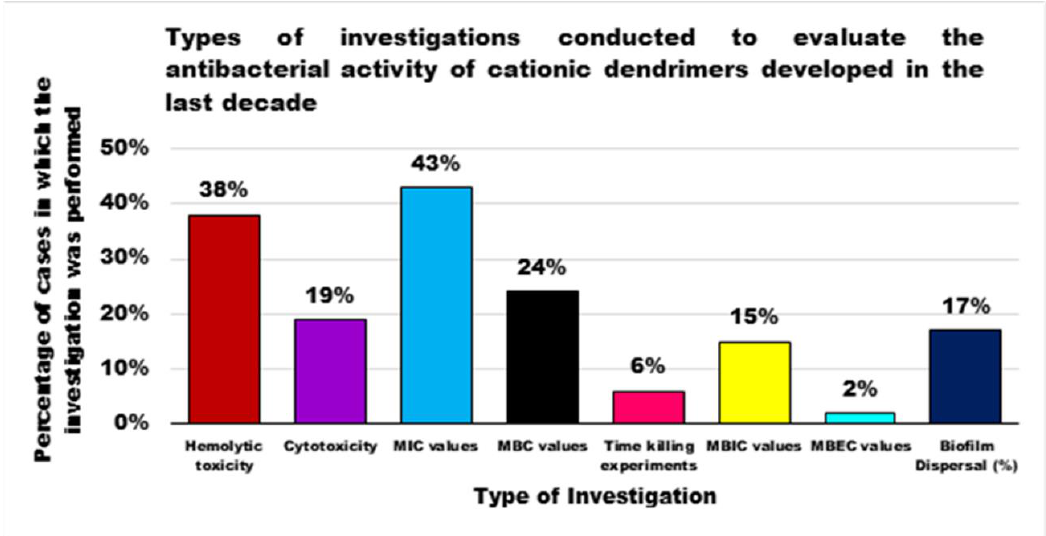
Figure 7. Percentages of the main biological investigations conducted on CADs developed in the years 2010–2020.